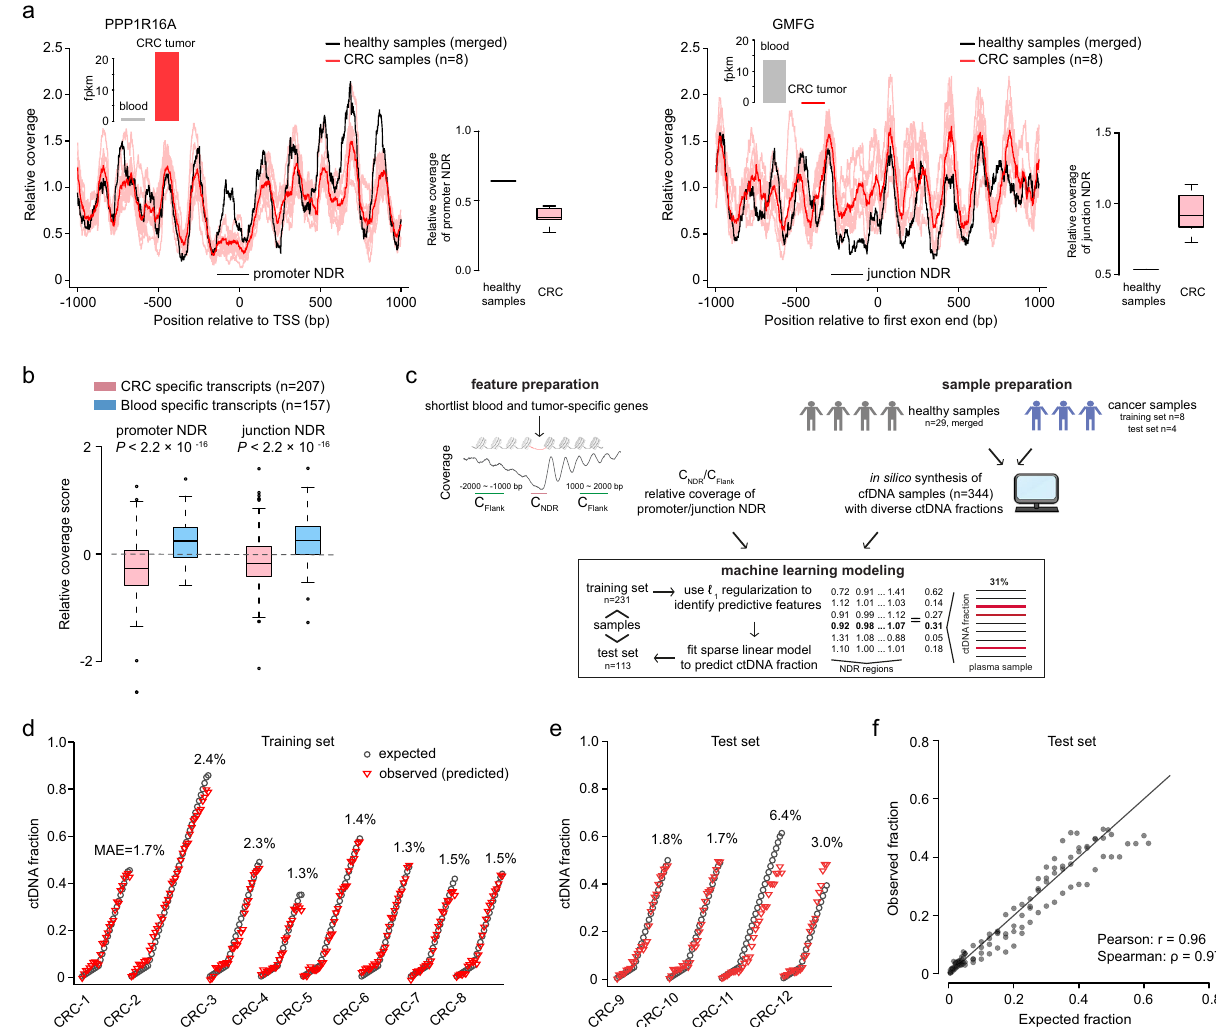
Fig. 3 Quantitative estimation of colorectal cancer ctDNA burden. a cfDNA relative coverage for the promoter region of PPP1R16A (ENST00000528430) overexpressed in CRC tumors relative to whole blood, and cfDNA relative coverage for the junction region of GMFG (ENST00000602185) overexpressed in whole blood relative to CRC tumors. The dark red curve shows the mean coverage across CRC samples. b Relative coverage score (see Methods) of NDRs in transcripts differentially expressed between CRC tumors and whole blood. Two-sided Wilcoxon rank-sum tests were performed to compare CRC and blood-speci fi c transcripts. c Schematic showing how the predictive model of ctDNA fractions was developed: differentially expressed genes in CRC and blood were identi fi ed, NDR relative coverage features were obtained from in silico generated cfDNA samples, predictive features were selected, and a quantitative model was fi tted. d , e Comparison of expected (in silico simulation) and observed ctDNA fractions across the CRC cfDNA samples in the d training and e test set, respectively. The mean absolute error (MAE) is listed for each sample. f Comparison between observed and expected ctDNA fractions of the 113 samples in the test set. Boxplots represent the median as centreline, the interquartile range (IQR) as bounds of box, and the lower quartile – 1.5 IQR and the upper quartile + 1.5 IQR as whiskers.